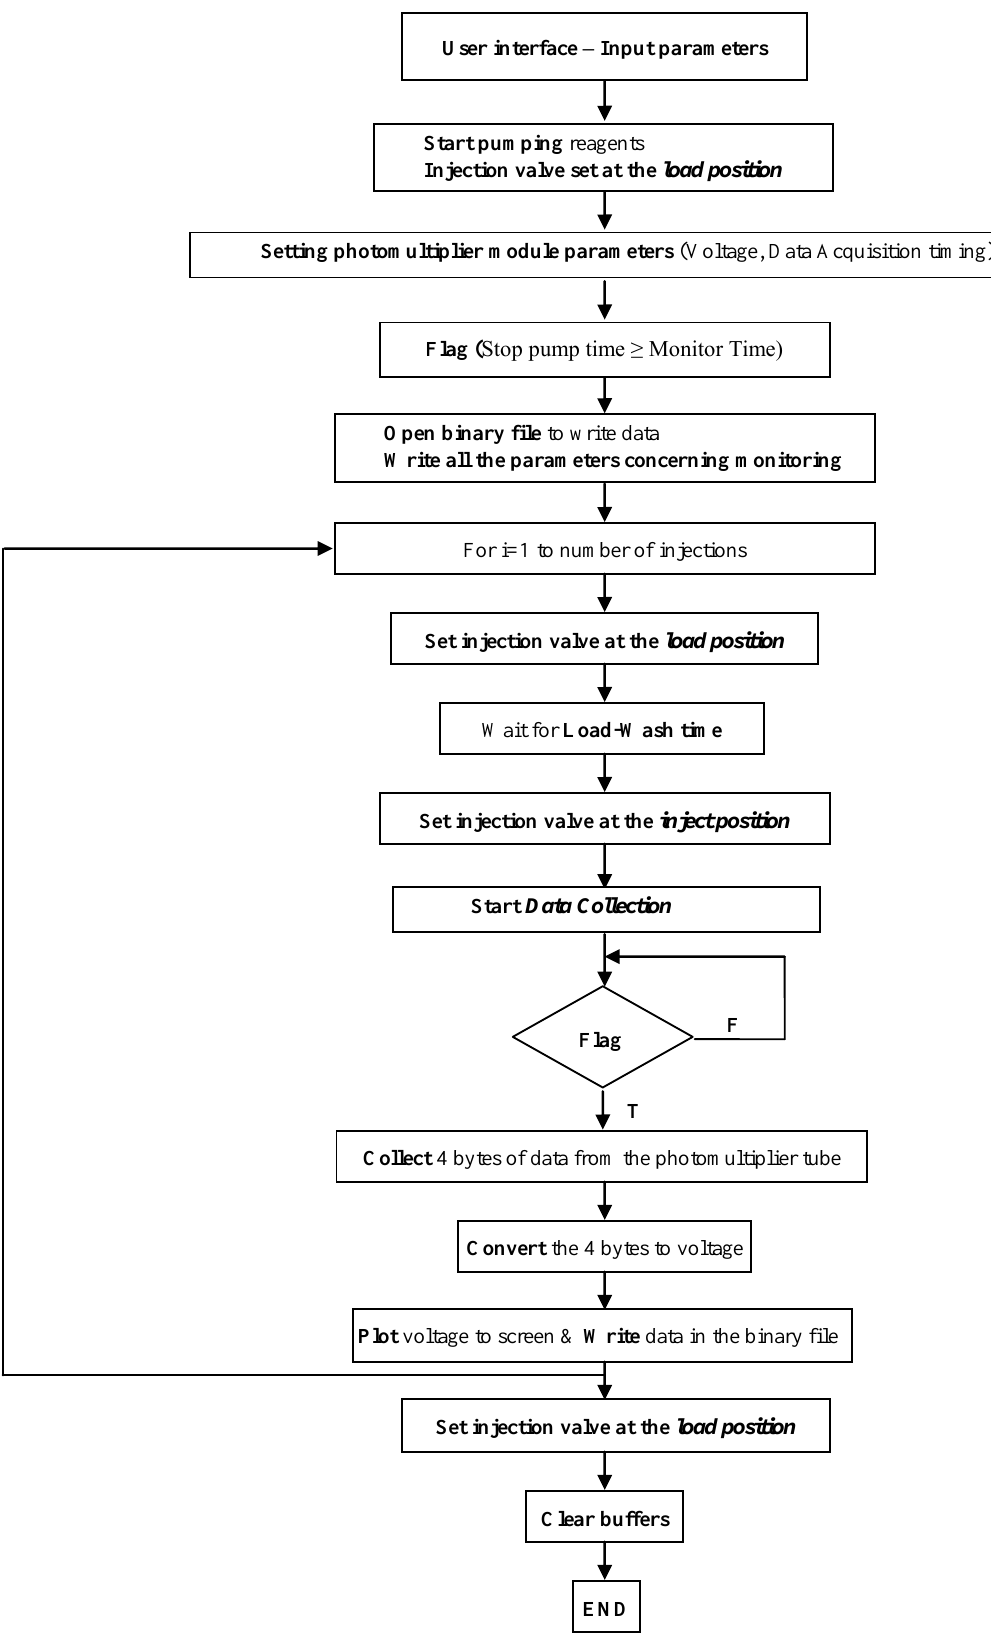
Figure 4. Data acquisition and control program flow chart. F : false; T :